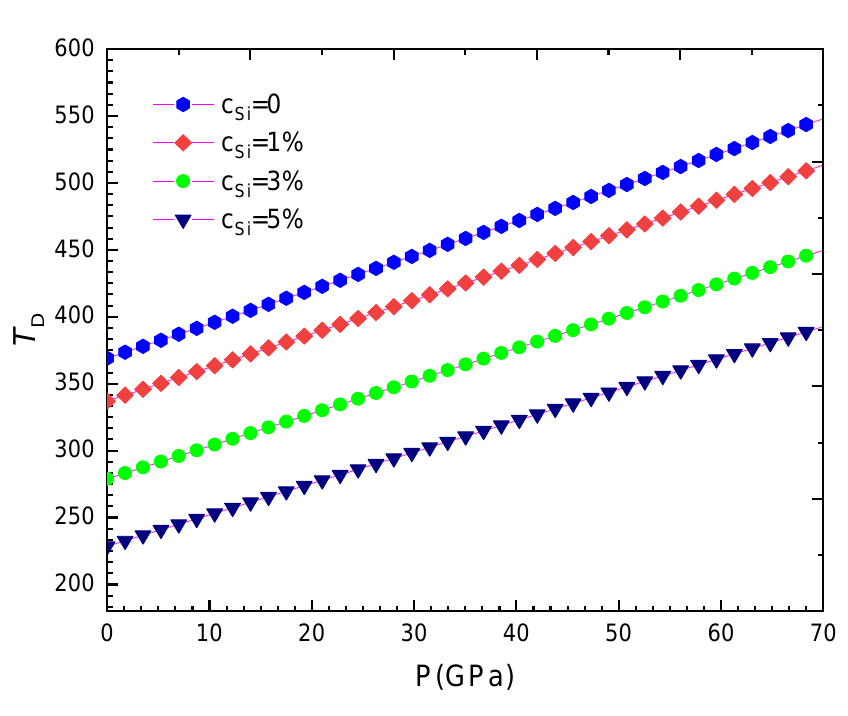
Figure 6. For WSi at T = 300 K.